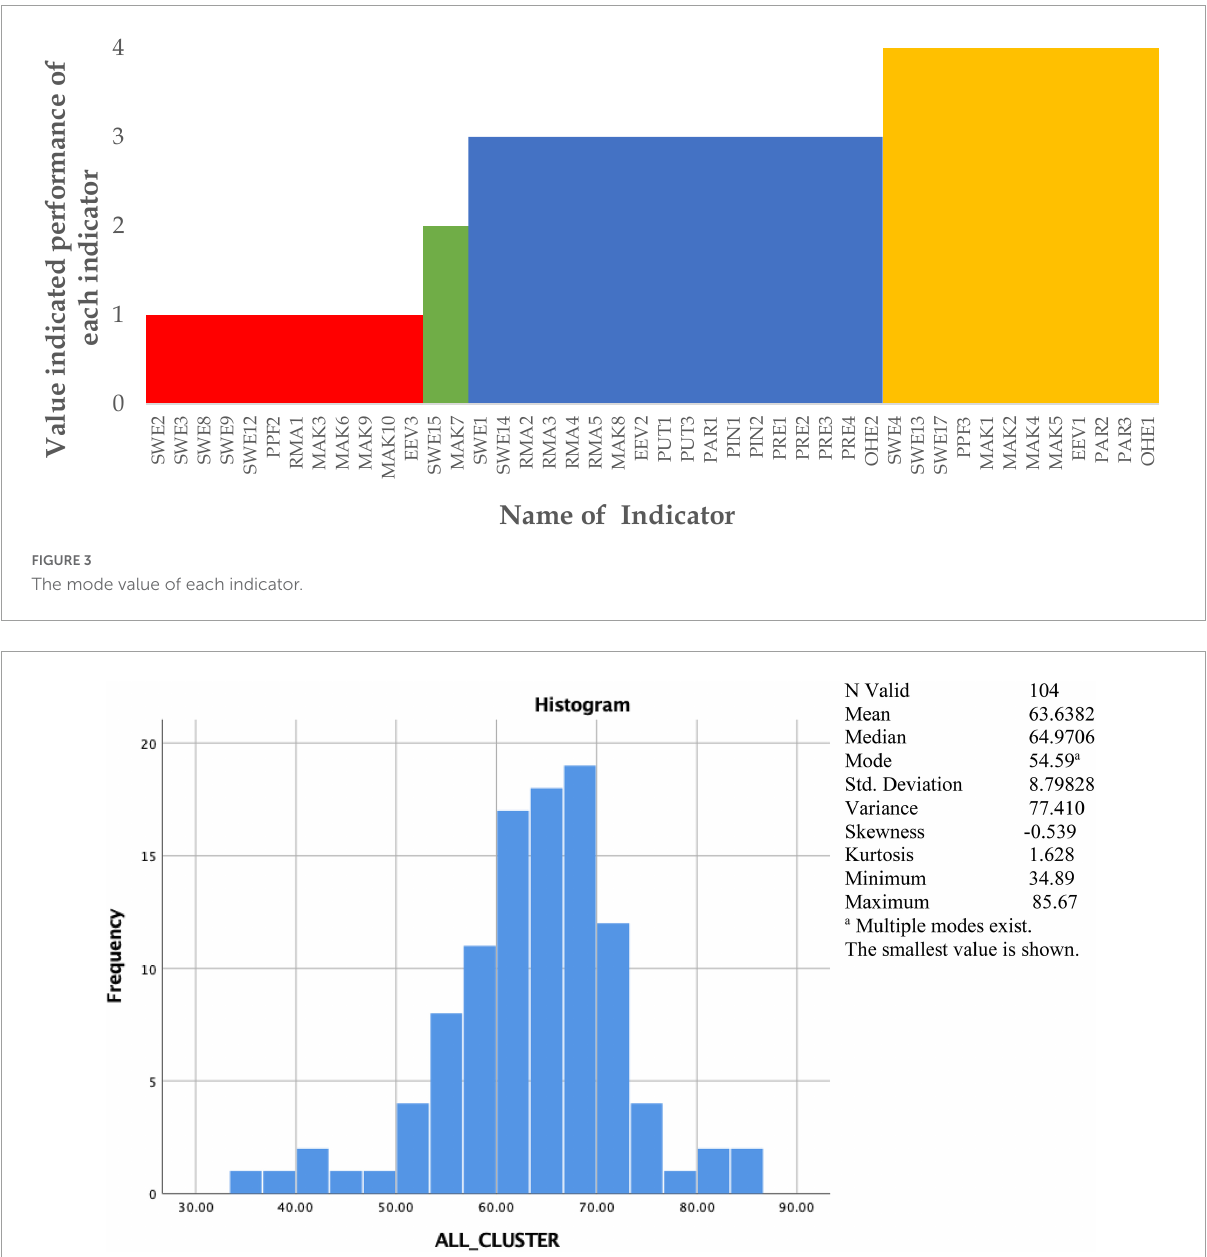
FIGURE4 Histogram and the profile of total value of vulnerability given to each of the 104